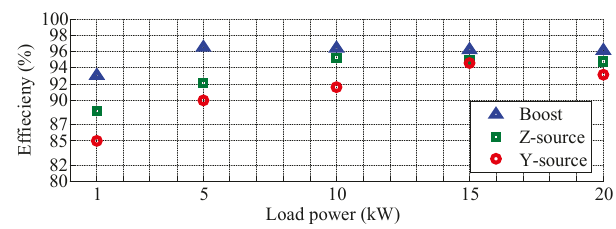
Table VIII. The switching and the conduction losses are